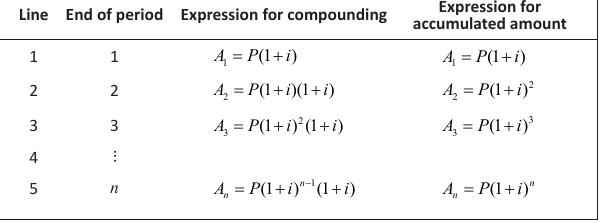
FIGURE 4: A multiplicative approach to deriving the compound interest